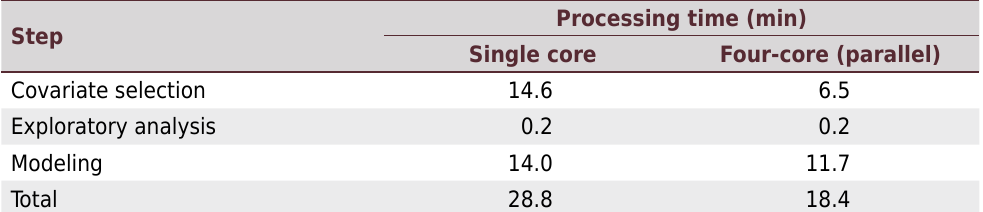
Table 7. Processing times for pH 0.00-0.30 m with(out) parallel